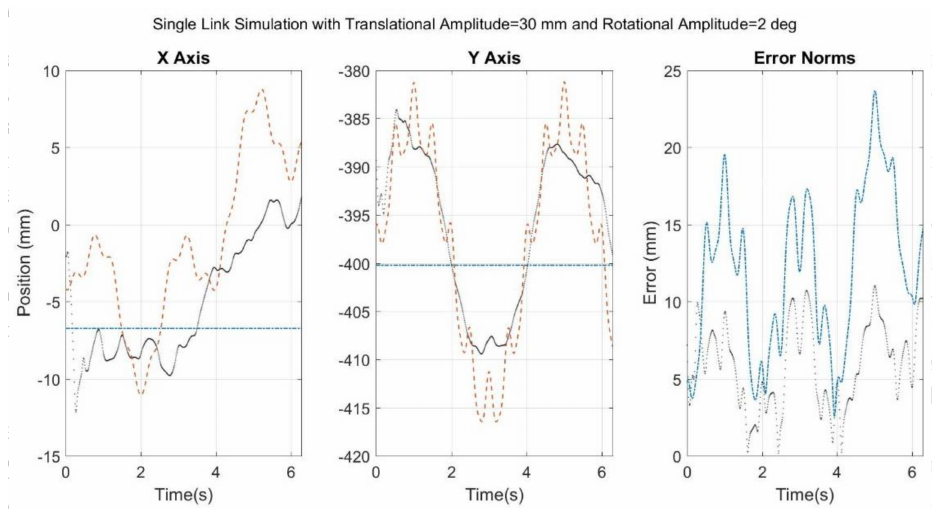
Figure 10. Results for simulation run with noise added to the rigid link, as well as the multimodal implementations of translational and rotational STA, as defined by Equations (3) and (4). Black dots refer to SFO, blue dash-dots to SOM, and red dashes to the